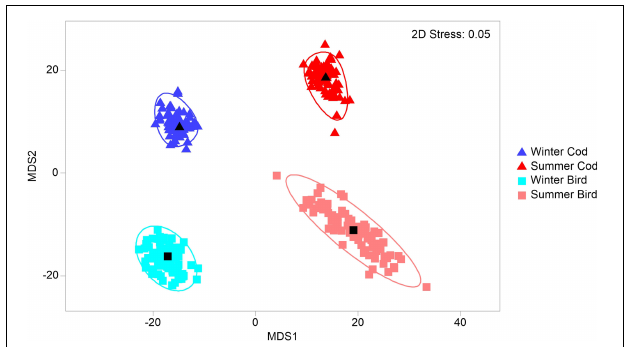
FIGURE 6 | Bootstrap average MDS plot of scavenger assemblages from different bait types (cod, bird) and seasons (winter, summer) calculated on the basis of Bray–Curtis dissimilarities after a transformation using dispersion weighting of average abundances (for n = 12